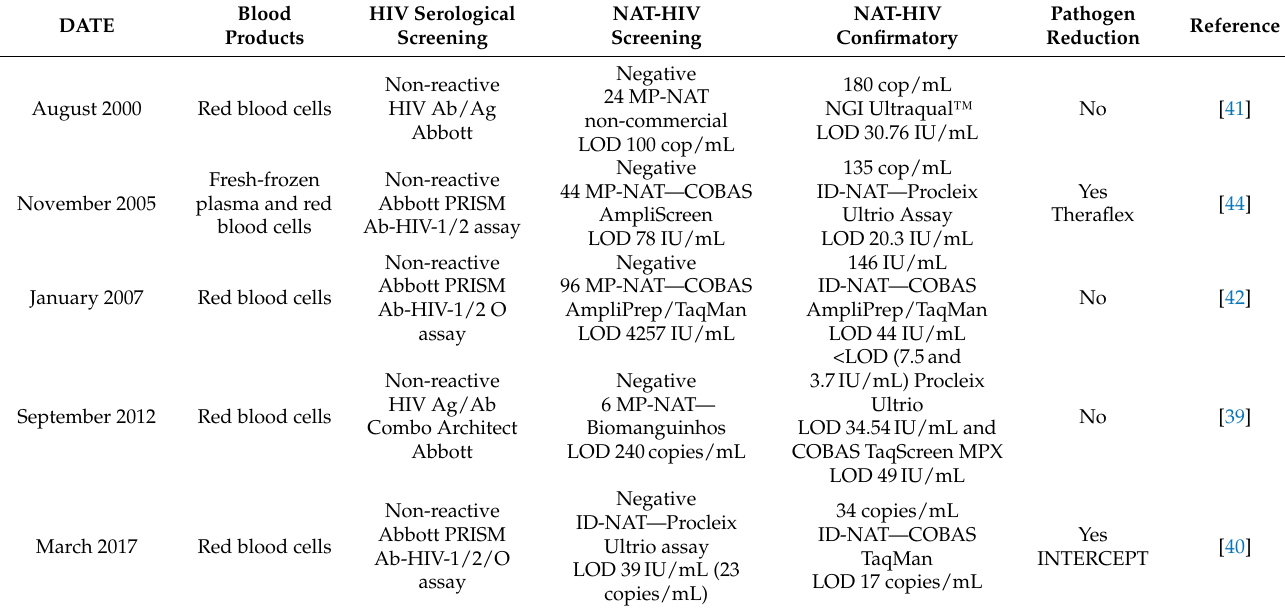
Table 1. HIV serology and molecular test results from HIV-infected blood products despite being negative for transfusion